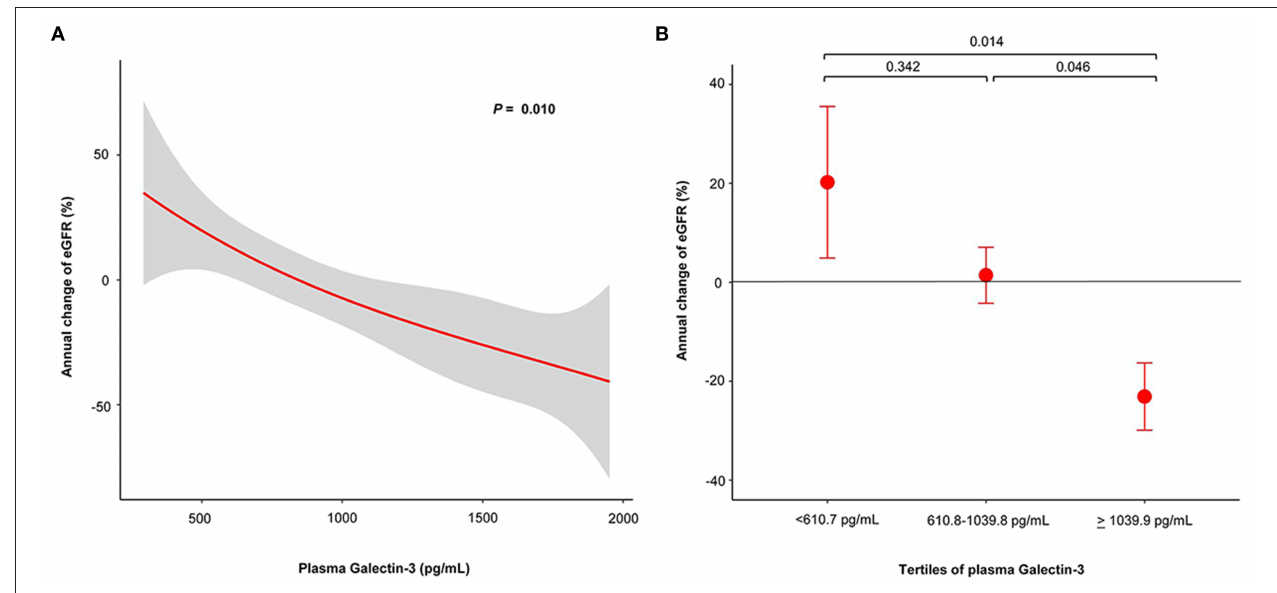
FIGURE 2 | Plasma Gal-3 predicts risk of annual change of eGFR in non-CKD patients whose eGFR > 60 ml/min/1.73 m 2 . (A) Restricted cubic spline plots of the association between annual change of eGFR and plasma Gal-3 levels. The red line indicates the change of eGFR with the respective 95% confidence interval (gray area). (B) Annual change of eGFR according to tertile of plasma Gal-3 levels. Gal-3, Galectin-3; eGFR, estimated glomerular filtration rate; CKD, chronic kidney